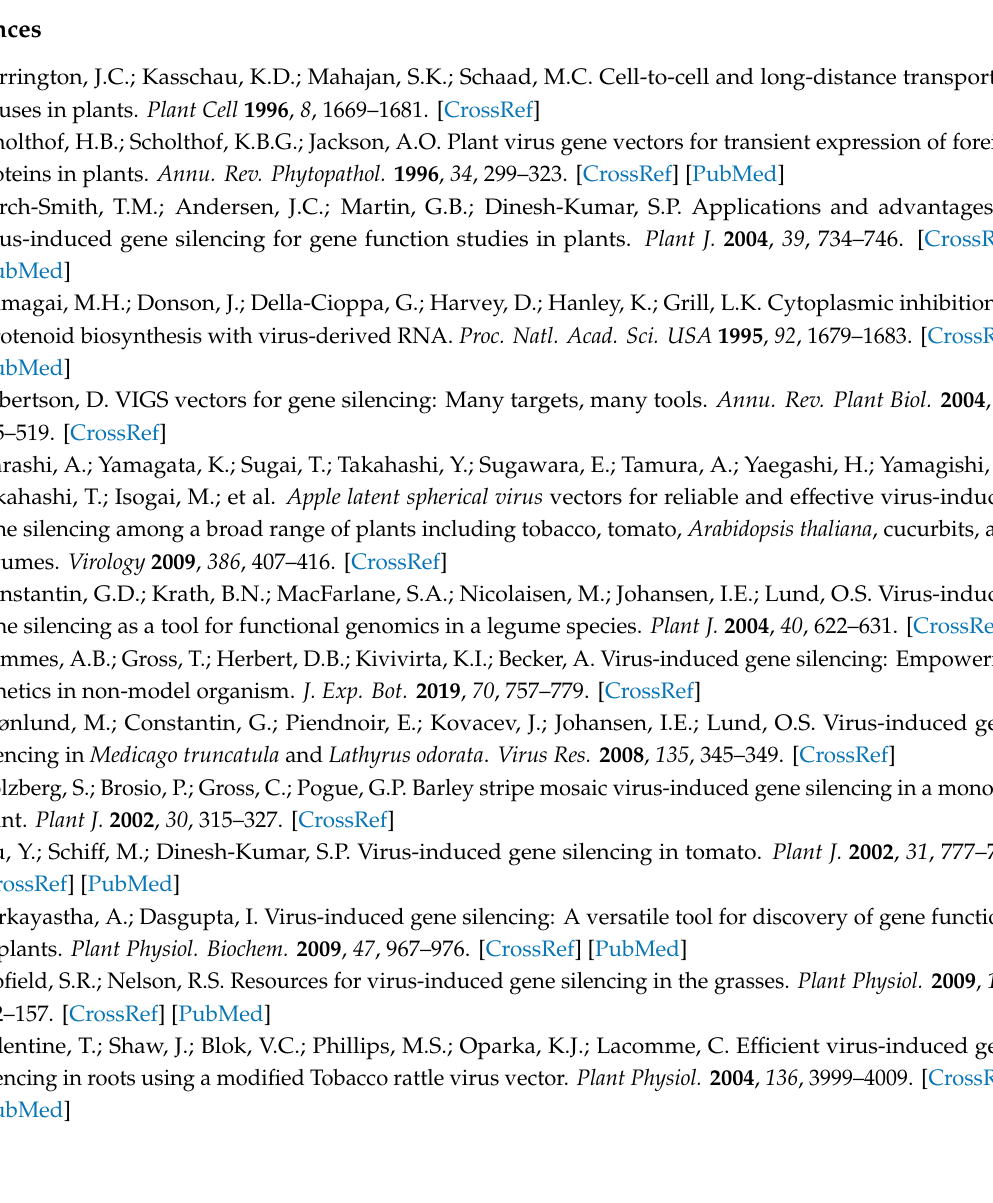
Table S1: Primers used for construction and detection of ALSV vectors, Table S2: Contents of sugar, acid, and